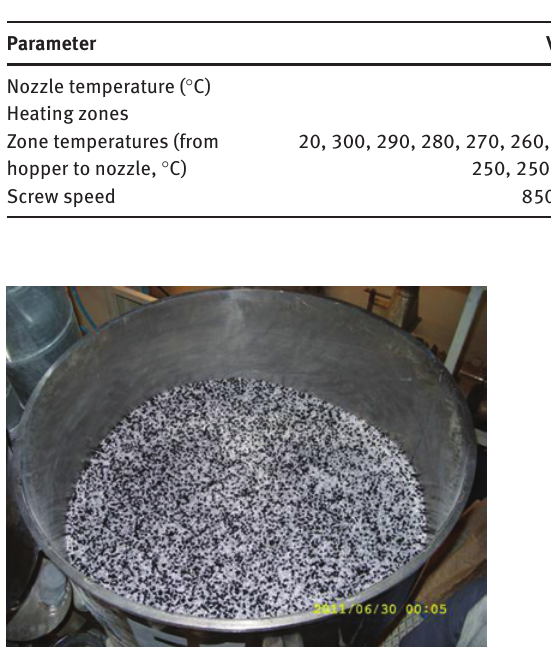
Table 3 Parameters for extrusion molding.